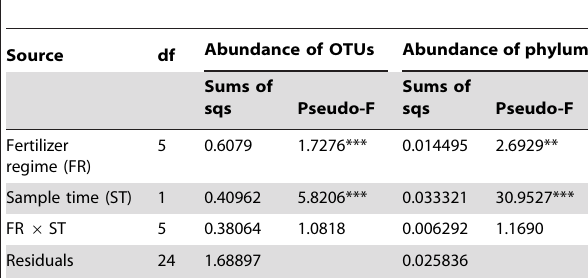
Table 4. Permutational multivariate analyses of variance of the Bray dissimilarity between bacterial communities.